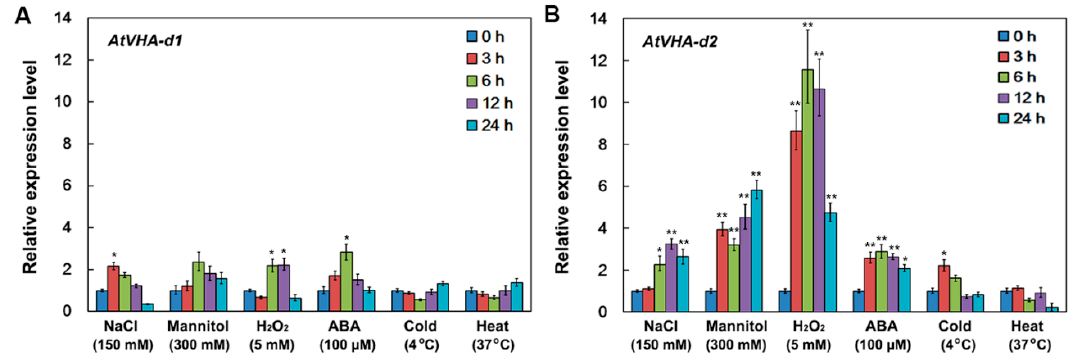
Figure 4. Expression analysis of AtVHA-d1 and AtVHA-d2 under multiple stresses. Ten-day-old Arabidopsis seedlings were treated with 150 mM NaCl, 300 mM mannitol, 5 mM H 2 O 2 , 100 µM ABA, 4 °C (cold), or 37 °C (heat) for 0, 3, 6, 12, and 24 h. The expression of AtVHA-d1 (A) and AtVHA-d2 (B) was investigated by qPCR. The AtActin2 gene was used as an internal control, and the transcript level in untreated seedlings was set as 1.0. Asterisks indicate a significant difference between untreated and stress-treated seedlings (* p < 0.05; ** p < 0.01; Student ′ s t -test). Error bars represent the SD ( n = 3).